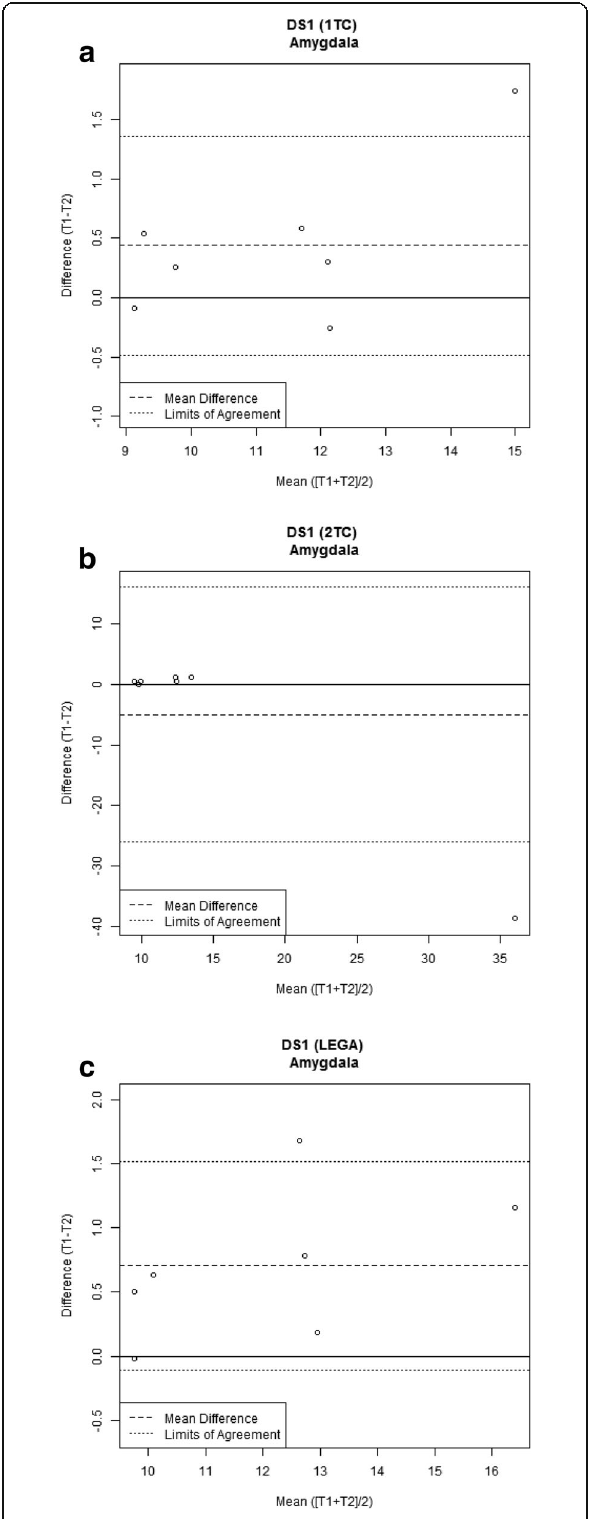
Fig. 4 Bland-Altman plots of the [ 11 C]CUMI-101 dataseDS1 for a 1TC model, b 2TC model, and c LEGA